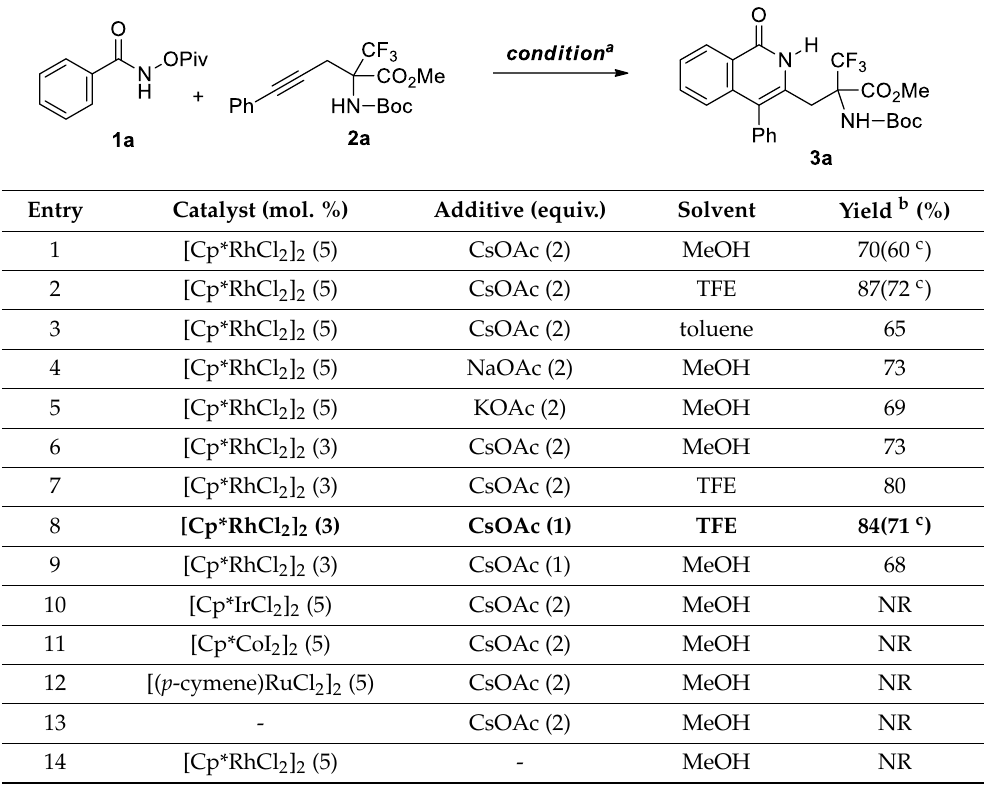
Table 1. Optimization of [4+2]-annulation of aryl hydroxamate 1a with acetylene 2a .